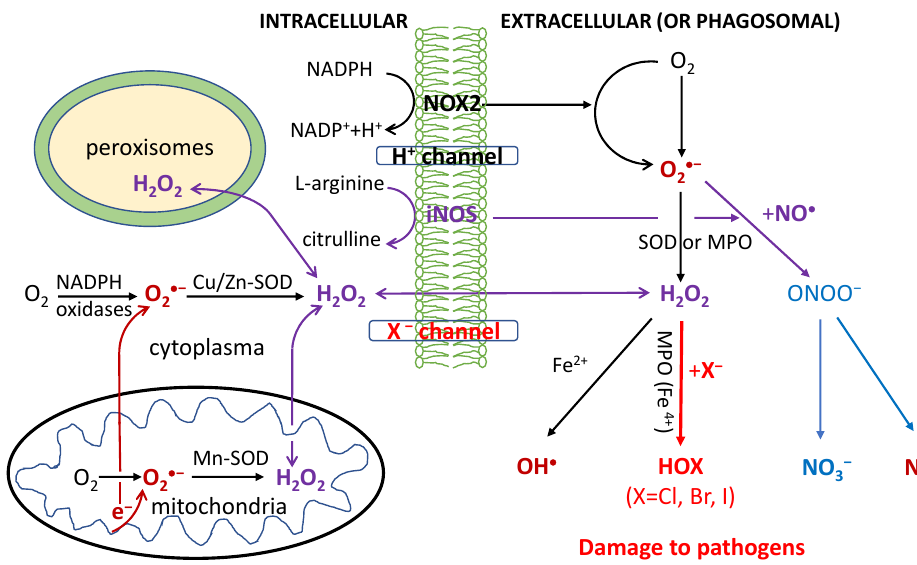
Figure 1. Respiratory burst in the immune defense against pathogens in phagocytosis.